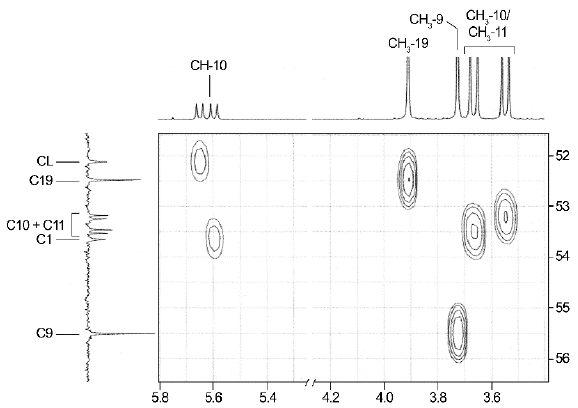
Figure 5. Partial spectra of heteronuclear single quantum correlation (HSQC) experiment showing key HC-correlations for both CH-1 and CH 3 O signals.